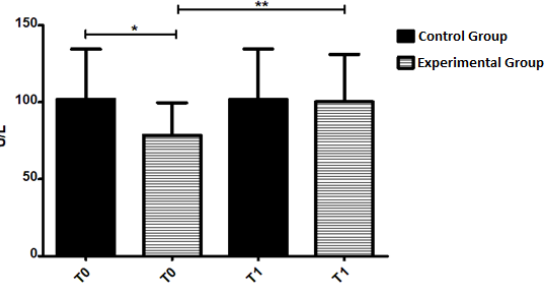
Figure 2. Glutathione Reductase activity at T0 and T1 of control and experimental groups. The results are expressed as U/L and as mean ± standard deviation. * p < 0.05, ** p < 0.005.